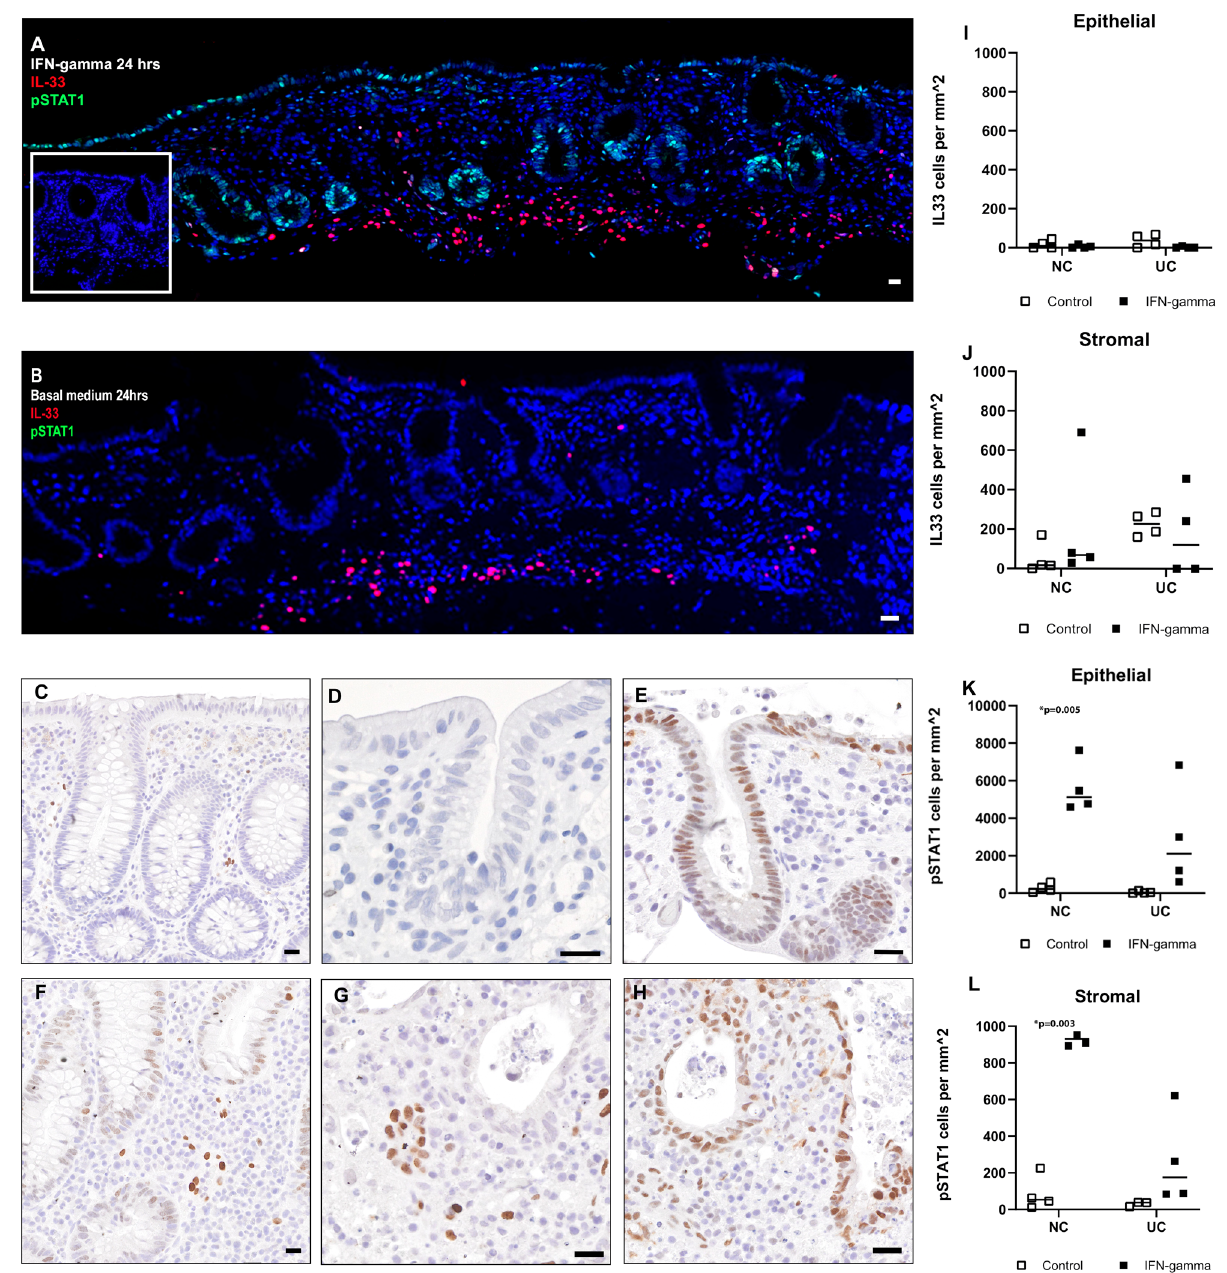
Figure 4. IFN-gamma stimulation . Image ( A,B) show immunofluorescence staining of quiescent UC (Mayo score ≤ 2) in colonic biopsies for IL-33 (red) and pSTAT1 (green) and nuclei counterstained with Hoechst (blue). Image ( A) shows a strong pSTAT1 signal in epithelial cells following 24 h of IFN-gamma 100 ng/ml stimulation for 24 h. Infelt to the left is an isotype and concentration matched control. Image ( B) shows the control biopsy cultured in basal medium for 24 h (non-stimulated) with no pSTAT1 epithelial signal. Immunoenzymatic staining for IL-33 (brown) is shown in a healthy control ( C,D) , Baseline biopsy at 0 h (image C ) and following 24 h of IFN-gamma stimulation (image D ) Further pSTAT1 (brown) staining is shown in image E after 24 h 100 ng/ml IFN-gamma stimulation. Acute UC (Mayo score = 6) is shown in ( F–H) . IL-33(brown) is shown in image ( F) (baseline 0 h) and image ( G) (stimulated 24 h with IFN-gamma). Image ( H) shows pSTAT1(brown) following IFN-gamma- stimulation for 24 h. Quantification of immunostaining is given in graphs ( I–L) . Healthy controls = NC. No significant presence of IL-33 was seen in the epithelium following IFN-gamma stimulation for 24 h. pSTAT1 was significantly increased in the epithelial border and stroma in both healthy controls (NC) and UC. Scale bars are given at 20